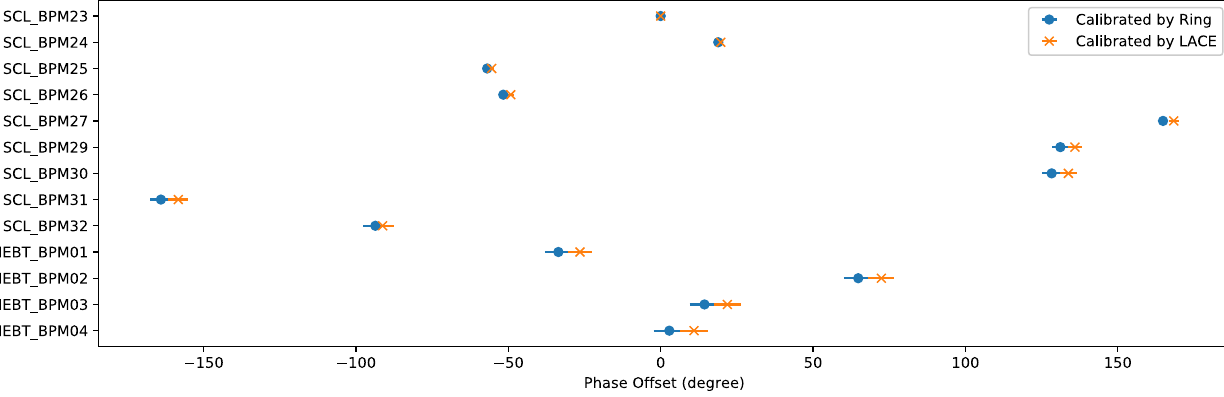
FIG. 4. Phase offsets, with error bars, of BPMs in the SNS SCL and HEBT from calibration experiments conducted in February (ring) and April (LACE) 2020. Each phase offset and its error are calculated using Eq. (18) and (A1) respectively.